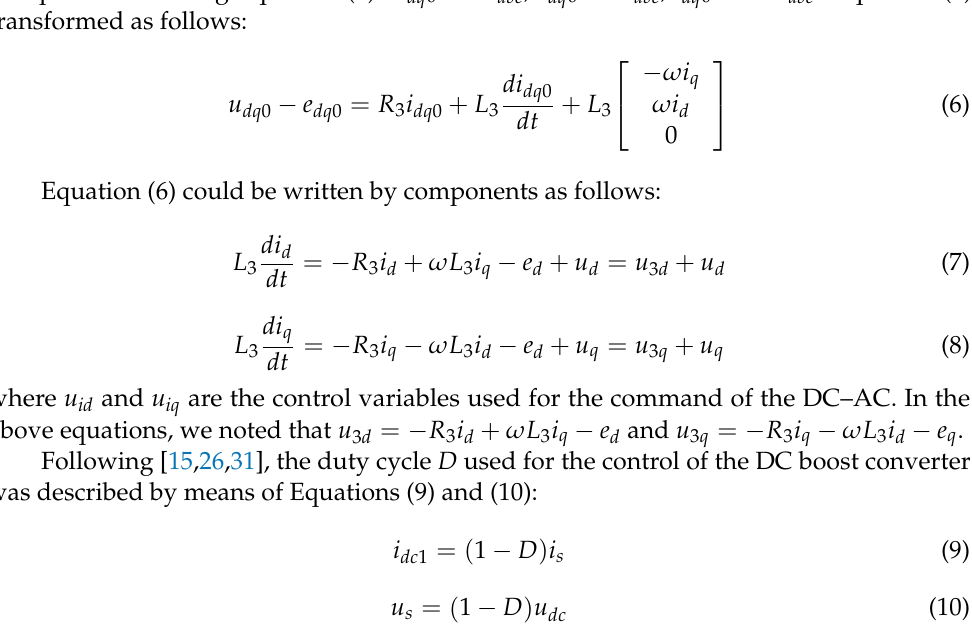
Figure 2. The chain of primary elements consisted of the following blocks: the simulated inputs for PV array; the PV array itself; the MPPT algorithm; the DC-DC boost converter; the voltage and current measurements for the DC intermediate circuit; the load and connection to power grid; the DC-AC converter; and the power grid. It can also be noted that the main element that we focus on in this article is the control block of the three-phase DC- AC converter. The main objective of the control system is to stabilize the u dc voltage as precisely as possible, including under variation caused by the three-phase load. While in the classic case, the control system is built with PI-type controllers for the two voltage and current control loops, this article presents an improvement in the performance of the control system through the use of an RL-TD3 agent. Furthermore, in the complex case of a control system in which the control of the voltage loop is performed by an SMC-type controller and the control of the current loop is performed by an SYN-type controller, there was an improvement in the performance of the GC-PV control system through the use of the RL-TD3 agent that was created and trained